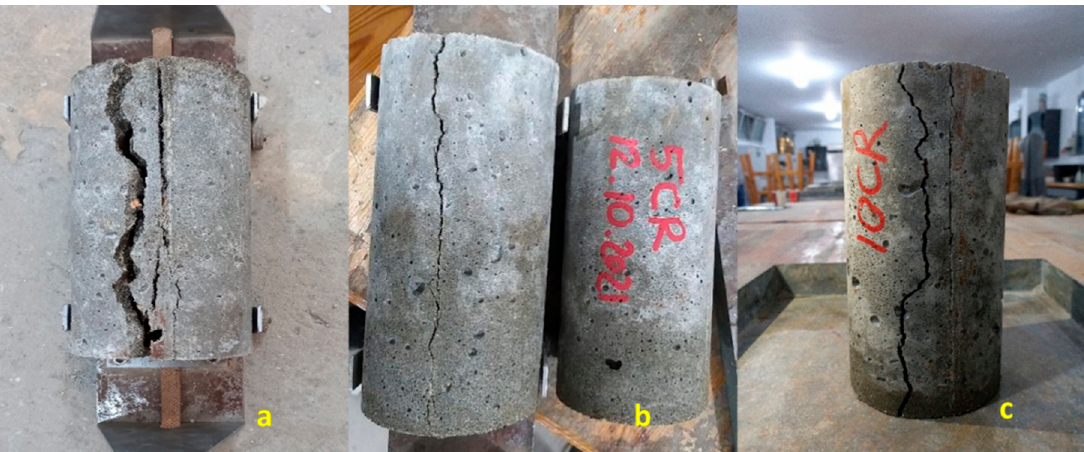
Figure 12. Failure modes of splitting tensile strength for different mixes: ( a ) control mix, ( b ) 5CR mix, and ( c ) 10CR mix.